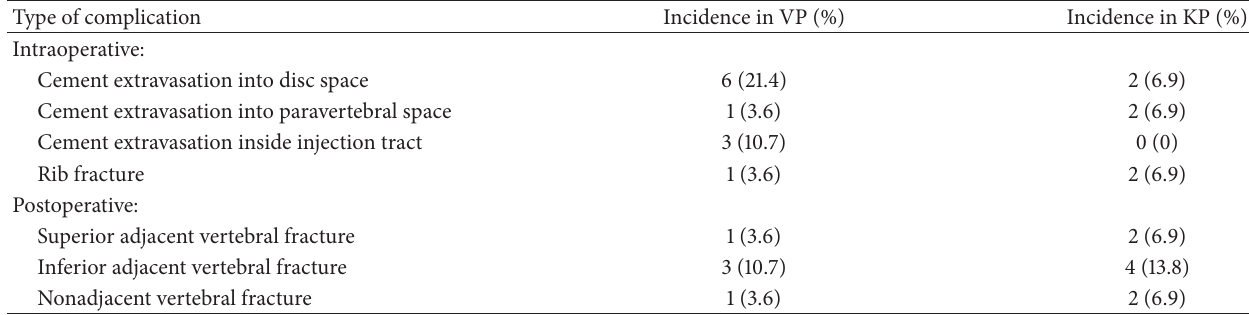
Table 2: Complications of cement augmentation procedures in our